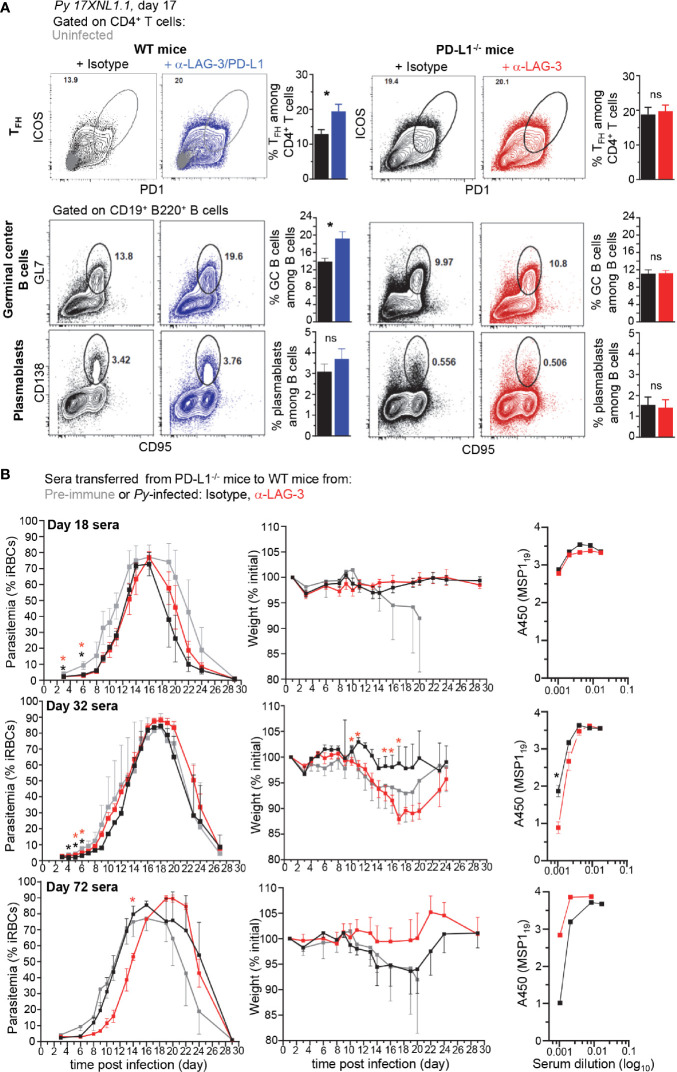
Lymphocyte Activation Gene 3 (LAG-3)/PD-L1 therapeutic blockade enhances TFH and germinal center (GC) responses while LAG-3 blockade in PD-L1-/- mice does not. (A) Wild-type (WT) B6 or PD-L1-/- mice were inoculated with 2x105
Py 17XNL1.1 iRBC i.v. and 9, 12, 15, and 18 days post infection, indicated mice either received 200 µg of either anti-LAG-3/PD-L1, anti-LAG-3 or isotype Ab i.v. Spleens were harvested 17 days post infection and stained for CD4, CD3, ICOS, PD-1 to monitor CD4+ TFH cell response (ICOS+PD-1hi corresponds to ICOS+Bcl6hi cells) (top panel) and for CD19, B220, GL7, CD138, CD95 to monitor B cell responses (lower panels). Representative FACS dot plots of one to two independent replicate experiments are presented (n=4–10), with an overlay of representative uninfected mouse in the WT top panel. Graphs average each experiment shown with SEM. Student t-test was conducted between groups and p-values are indicated when applicable (*p < 0.05). (B) 150 µl of sera harvested from mice 18, 32, or 72 days post Py-infection was transferred to naïve WT mice (3-5 mice/group) that were subsequently infected with 2x105
Py 17XNL1.1 iRBC i.v. Blood parasitemia and weight was monitored over 28 days. Titers of Py MSP119-specific IgG antibodies in indicated sera was measured by ELISA and reported as background subtracted A450 values. p-values are indicated when possible compared to pre-immune treatment or to isotype treatment by student t-test. Asterisk color indicate respective treatment group (*p < 0.05).